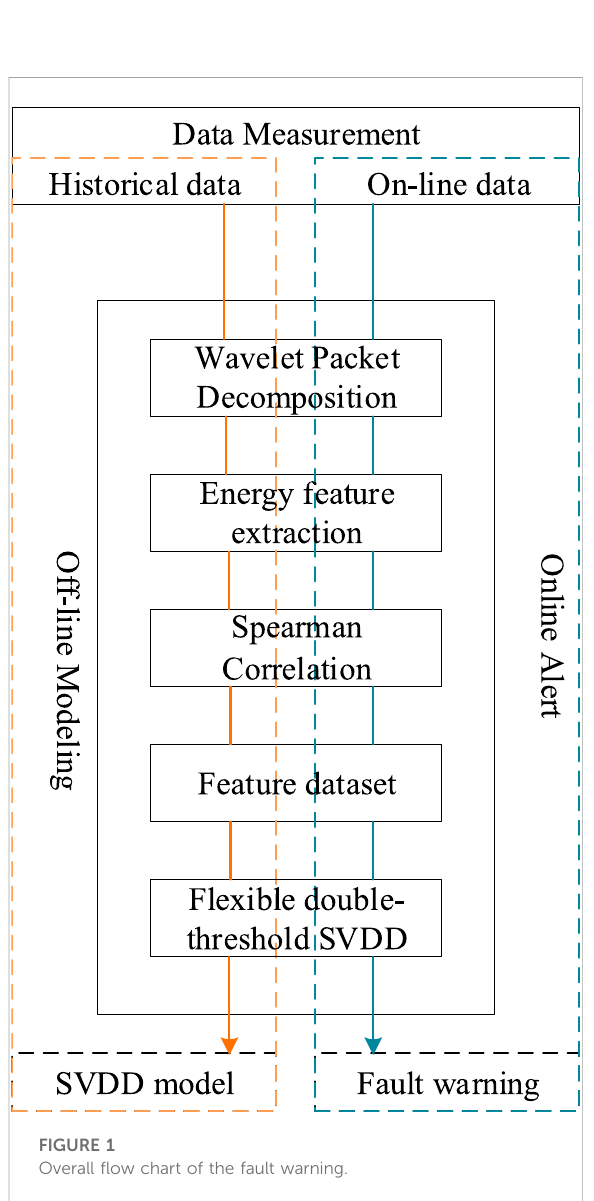
FIGURE 1 Overall fl ow chart of the fault warning.